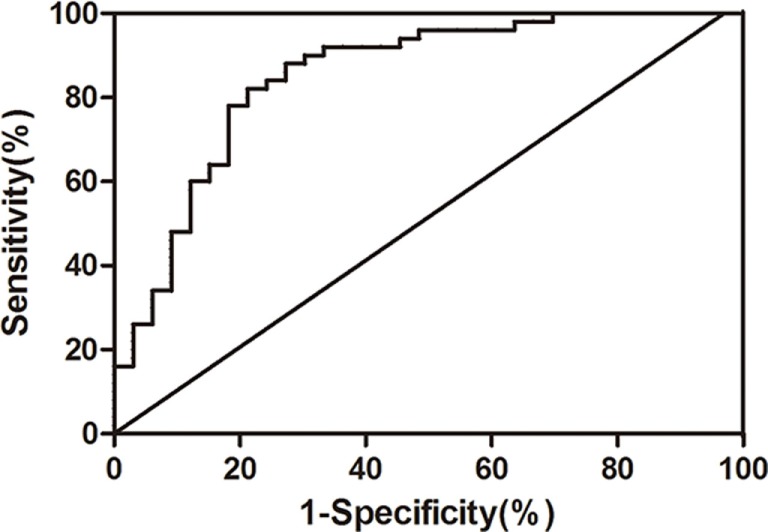
The receiver operating characteristic curve of serum exosomal miR-223 diagnosing ischemic stroke.